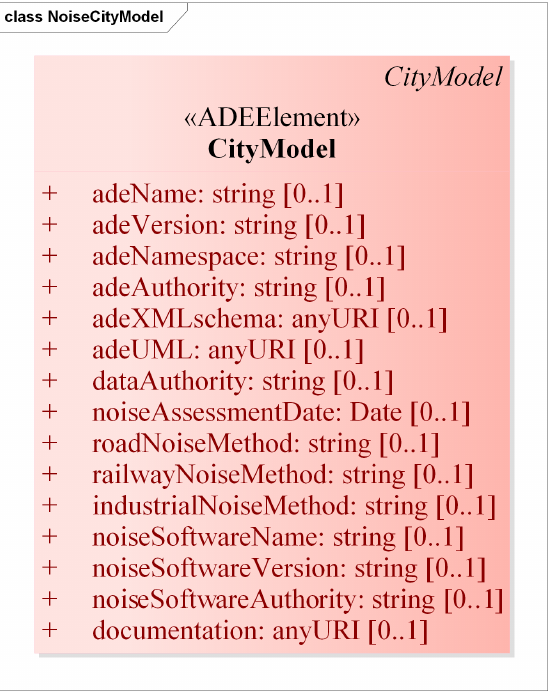
Figure 1. The Unified Modeling Language (UML) depicts the CityGML CityModel class extended to store the metadata attributes related to the eNoise ADE (Application Domain